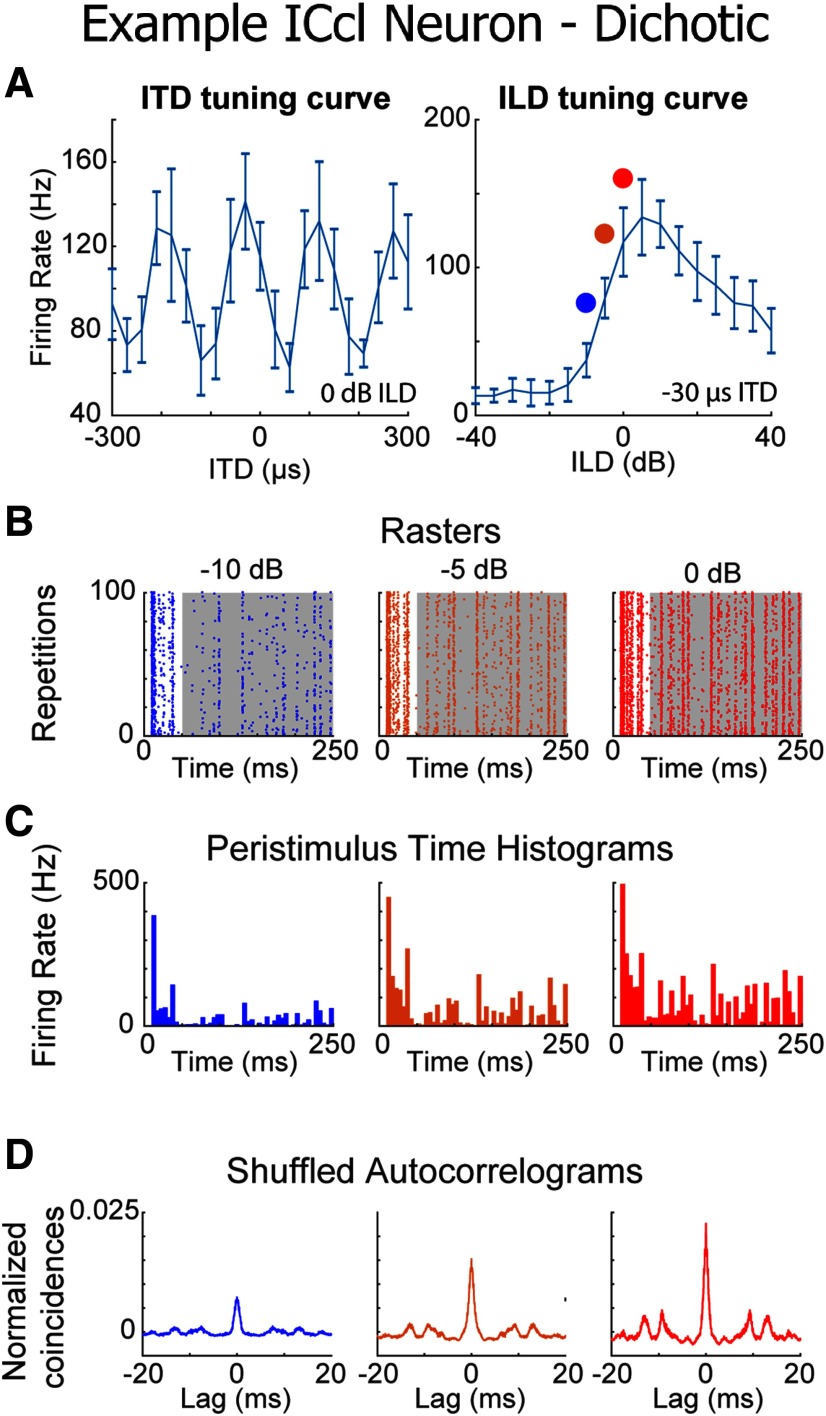
Reproducibility in ICcl to varying binaural cues. A, Tuning curves of an example ICcl neuron for ITD (left) and ILD (right). Positive ITDs and ILDs indicate, respectively, sounds leading and higher intensity on the right ear (contralateral side for the example cell). Colored dots in the ILD tuning curve are the examples displayed in B–D (plots represent mean ± SEM, n = 10 repetitions per trial). B, Example spiking raster plots of neuron shown in A at varying ILDs (indicated on top of each plot). Gray background represents region of stimulation used for SAC and distance analysis (50-ms onset omitted). C, Peristimulus time histograms generated from the raster plots in B (5-ms bin size). D, SACs generated from the rasters in B.